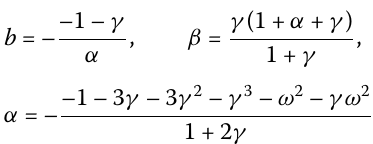
Distribution of